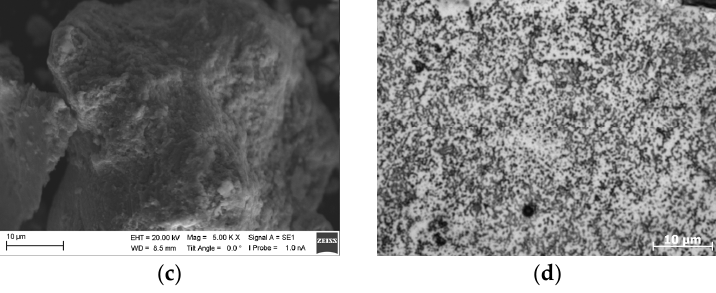
Figure 1. Morphology and microstructure of the following powder composites: ( a , b ) TiC-50% binder of high-chromium cast iron; and ( c , d ) TiC-50% binder of high-speed steel.